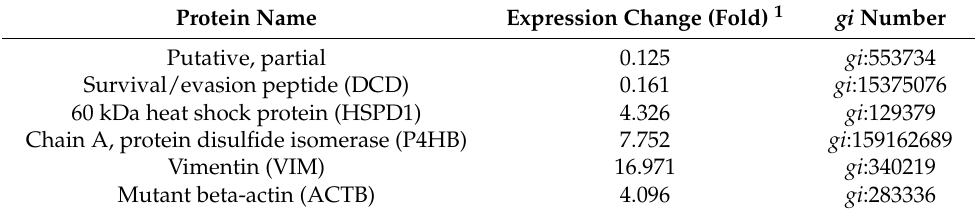
Table 3. Proteins identified by two-dimensional electrophoresis (2-DE) and LC-MS/MS.